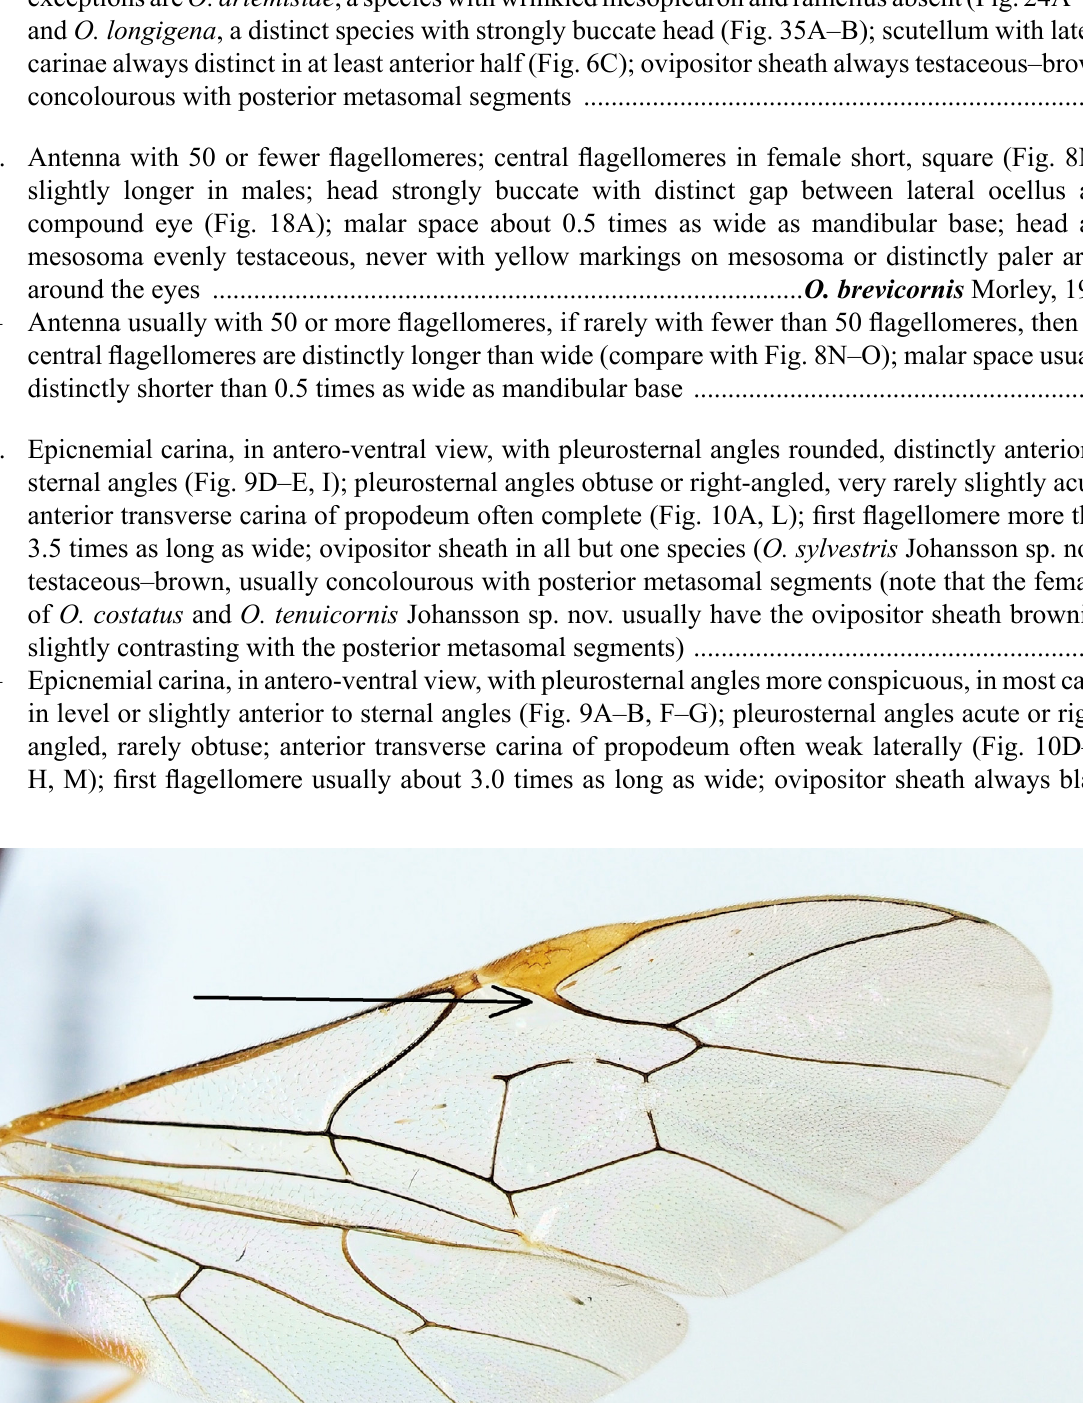
Sclerotised section of first sternite ending distinctly posterior to spiracle (Figs 6E‒F, 20E‒F) (the exceptions are O. artemisiae , a species with wrinkled mesopleuron and ramellus absent (Fig. 24A‒B), and O. longigena , a distinct species with strongly buccate head (Fig. 35A‒B); scutellum with lateral carinae always distinct in at least anterior half (Fig. 6C); ovipositor sheath always testaceous‒brown,